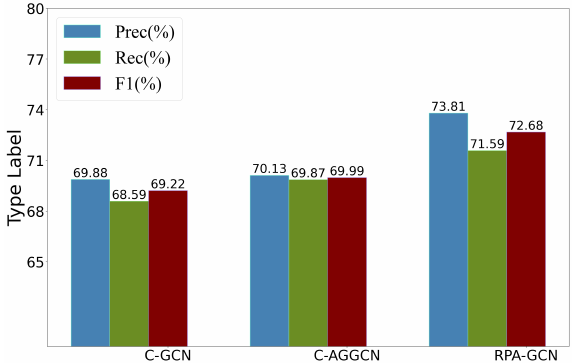
Figure 10. Value of precision, recall, and F1 of relationship type.